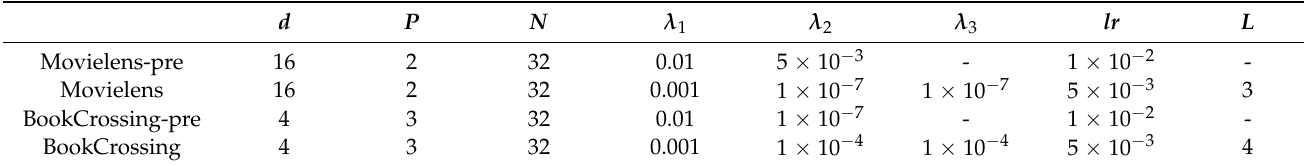
Table 2. The detailed parameters of the EKPNet